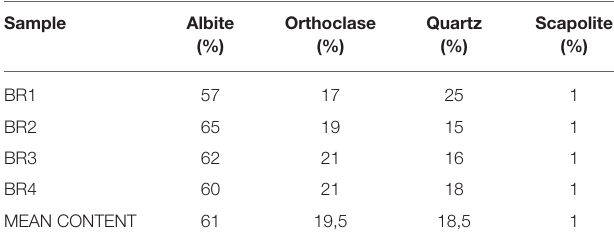
TABLE 1 | Mineralogical composition of the bedrock samples.